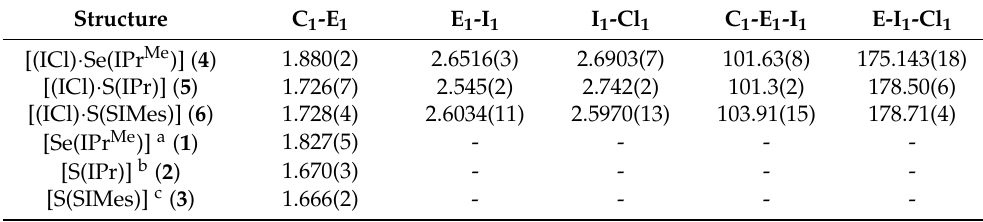
Table 1. Selected bond lengths (Å) and angles ( ◦ ) for the reported structures of [(ICl) · Se(IPr Me )] ( 4 ), [(ICl) · S(IPr)] ( 5 ) and [(ICl) · S(SIMes)] ( 6 ), and the NHC-based seleno- and thioureas [Se(IPr Me )] ( 1